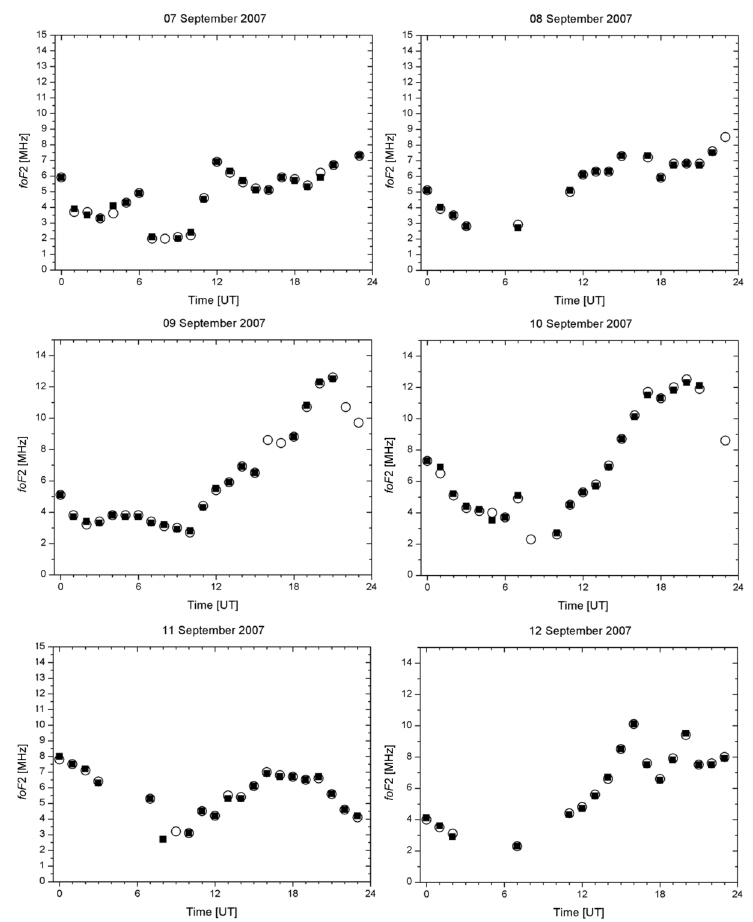
Fig. 6. Hourly foF 2 plots from 07 to 12 September 2007 as obtained by the ionograms recorded by the AIS- INGV ionosonde installed at Tucumán. Values manually scaled, and values obtained automatically by Autoscala, are indicated by open circles, and solid squares,